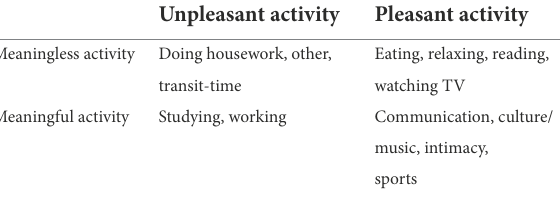
TABLE 5 Four types of activities: pleasant-meaningful, unpleasant- meaningful, pleasant-meaningless,